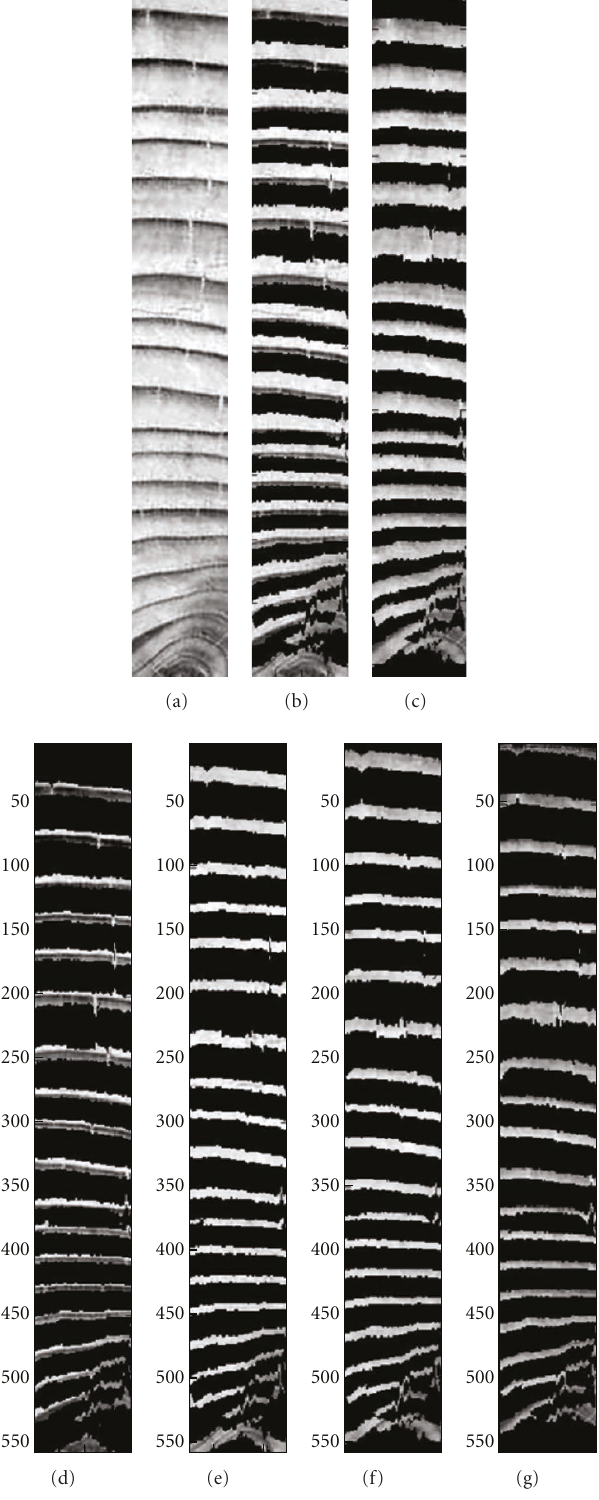
Figure 15: Tree growth estimates for hemlock sample using variable frequency spacing filterbank (sample 11 from Grissino Mayer database). (a)Original image, (b) first-half season,and (c) second-half season.Quarterly growth estimates: (d) 1st, (e) 2nd, (f) 3rd, and (g) 4th